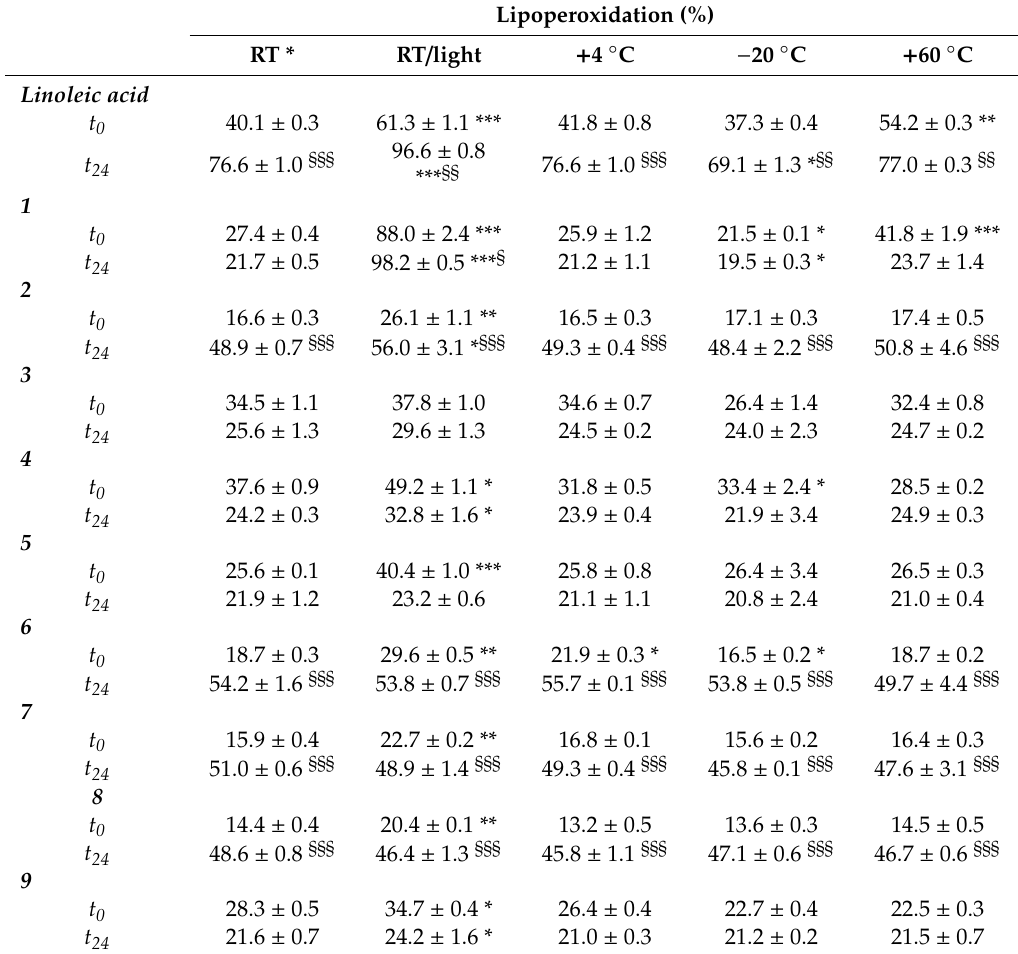
Table 5. Lipoperoxidation (%) of linoleic acid, used as standard, and the hemp seed oils 1–9 under di ff erent storage